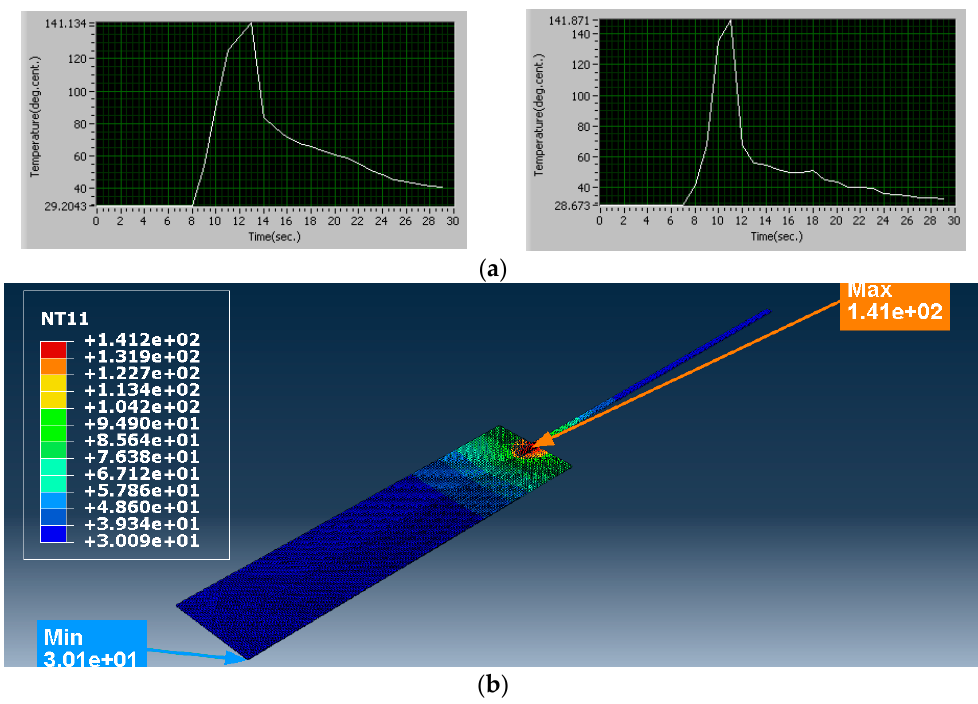
Figure 12. Trial 9, comparison of temperatures (°C): ( a ) results from experiments (Trial 9); and ( b ) result from simulation (Trial 9): Minimum temperature 30.09 °C, Maximum temperature 141.12 °C.